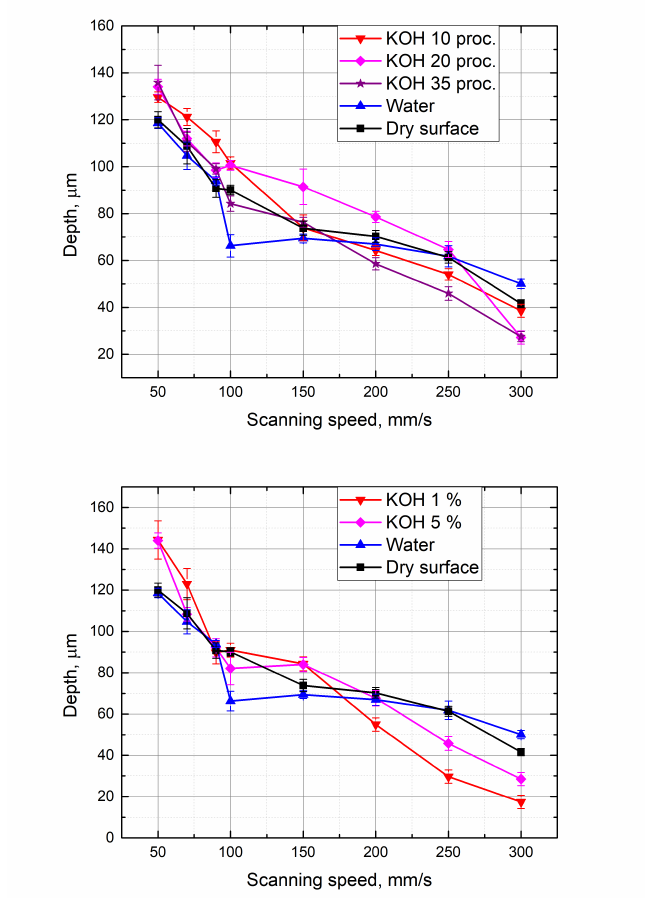
Figure 6. Depth of the grooves formed in the glass sample in dependence on the scanning speed. Grooves were formed while the glass sample surface was dry and immersed in different concentrations (1%, 5%, 10%, 20%, 35%) of KOH aqueous solutions, and water. Number of scans—15, average power—5 W, pulse repetition rate—60